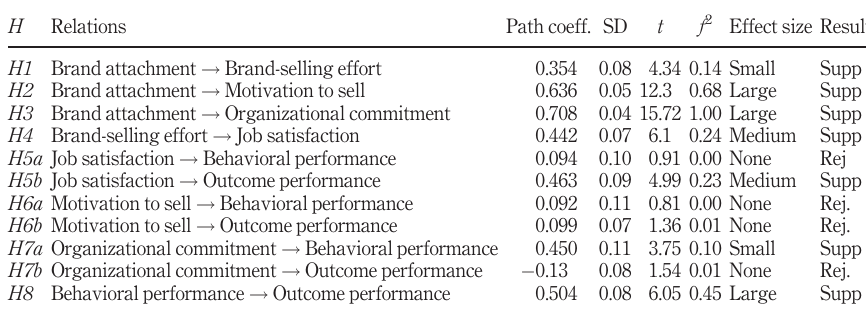
Table 3. Result of the